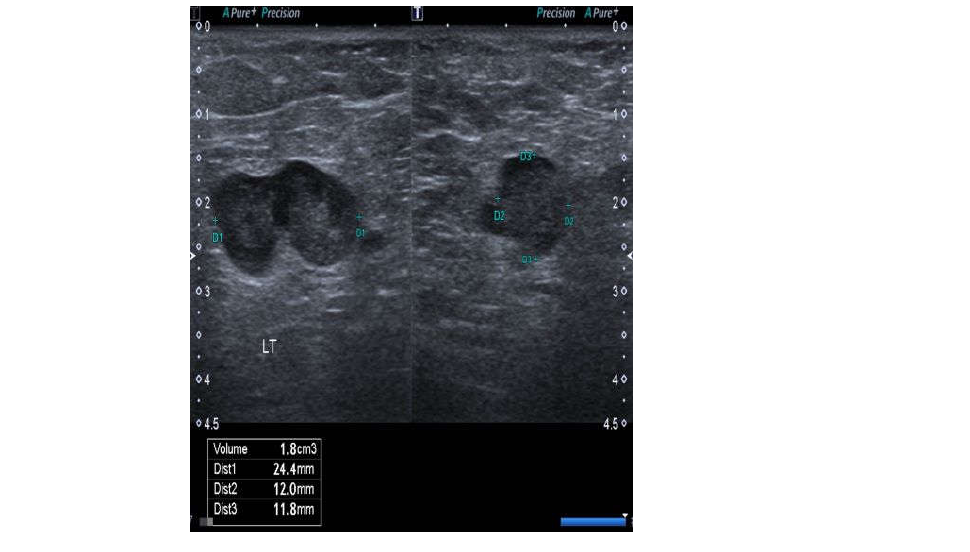
Figure 1. Case no. 10. Abnormal node from the right groin showing a lobulated surface contour of the cortex (or possibly two adherent nodes), interruption of the interface between the cortex and medulla, and a rounded rather than ovoid shape. All of these features suggest the tumor infiltration of the node.